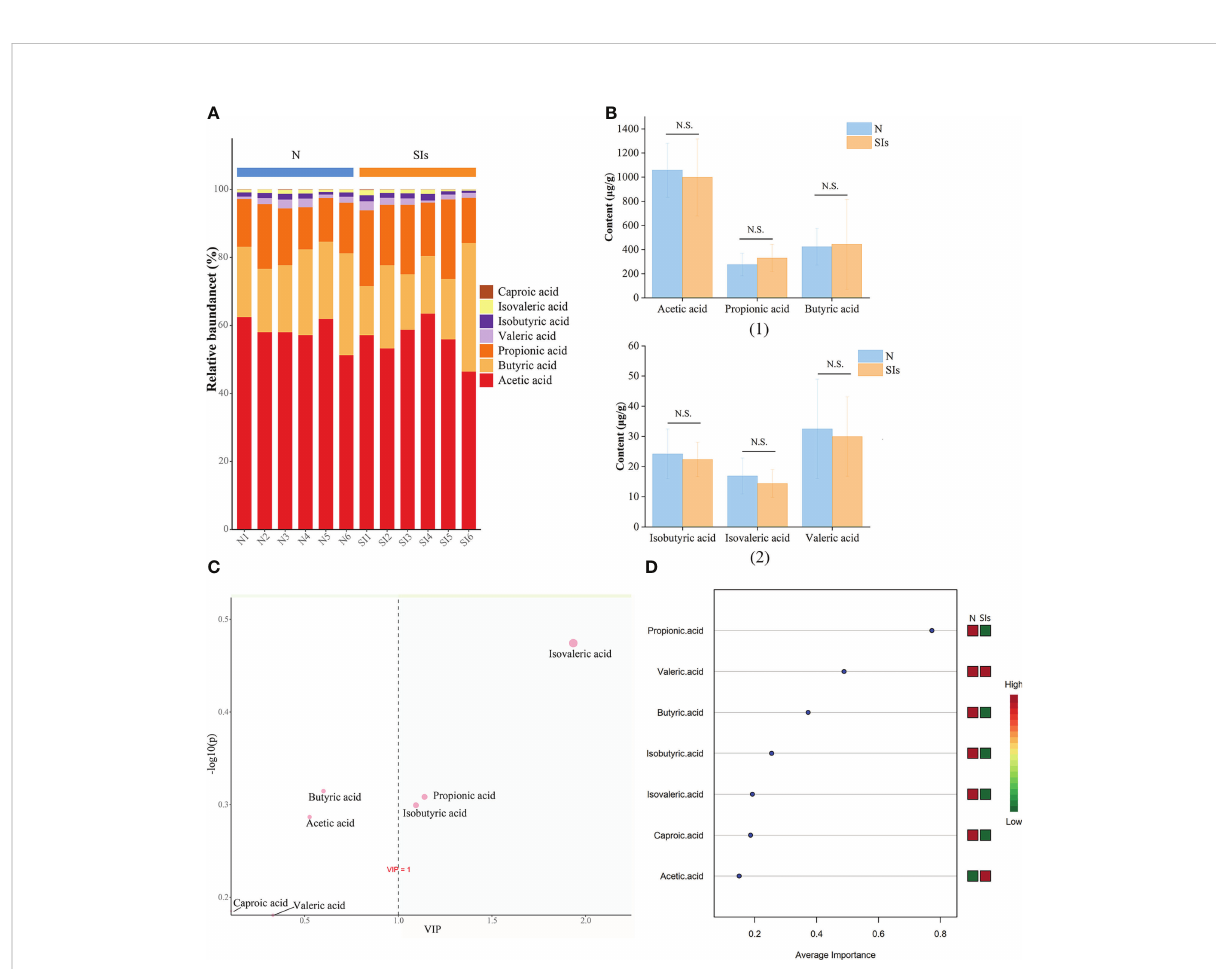
FIGURE 6 Effects of soybean iso fl avones on short-chain fatty acids (SCFAs) of normal mice ( n = 6). (A) The relative abundance difference of SCFAs between the two groups. (B) The content difference of SCFAs between the two groups. (C) Orthogonal partial least squares-discriminant analysis (OPLS-DA). (D) Support vector machines (SVM) analysis. N, normal group; SIs, soybean iso fl avones group. N.S., no signi fi cance (P >